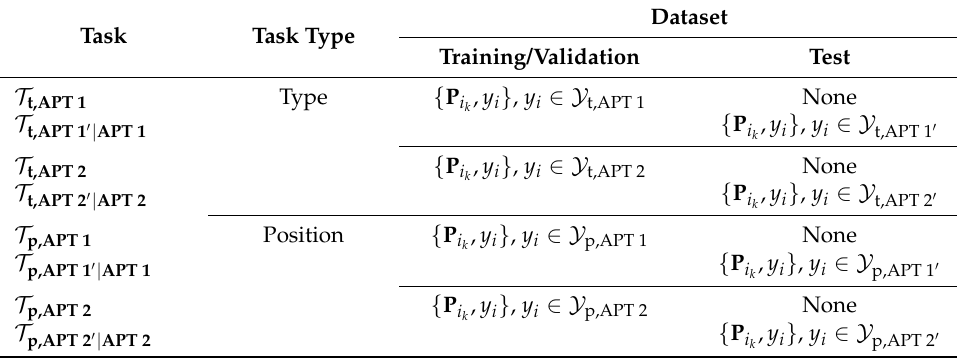
Table 1. Summary of the source type classification and localization tasks described in Sections 3.4.1 and 3.4.2 at the single apartment APT I and APT II.